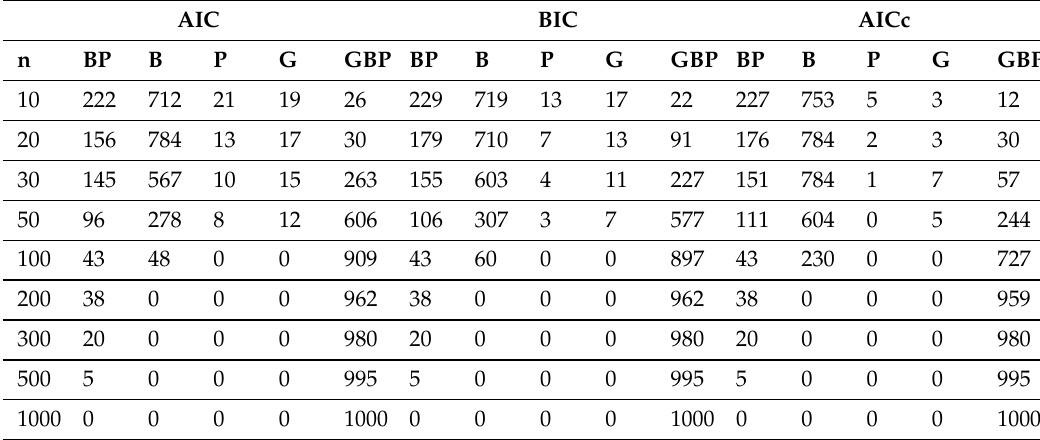
Table 7. Smaller AIC/BIC/AICc scores in 1000 simulations from a GBP distribution GBP ( α , β , k , θ , c